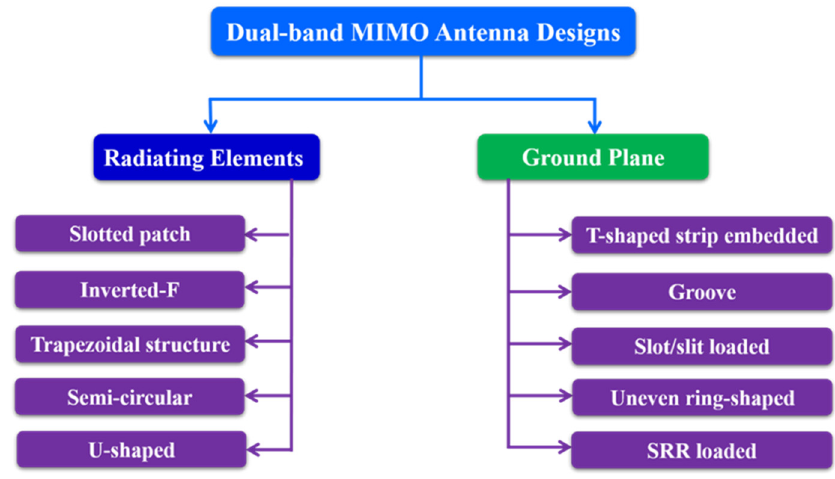
Figure 9. Dual-band MIMO antenna design approaches.